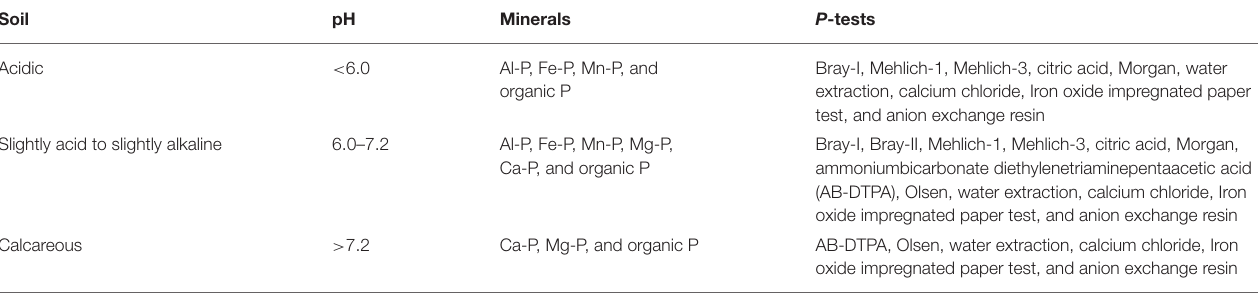
TABLE 1 | Selection of proper soil phosphorus test based on soil properties and targeted phosphorus species (Elrashidi, 2010; Zehetner et al., 2018; Kedir et al., 2021).